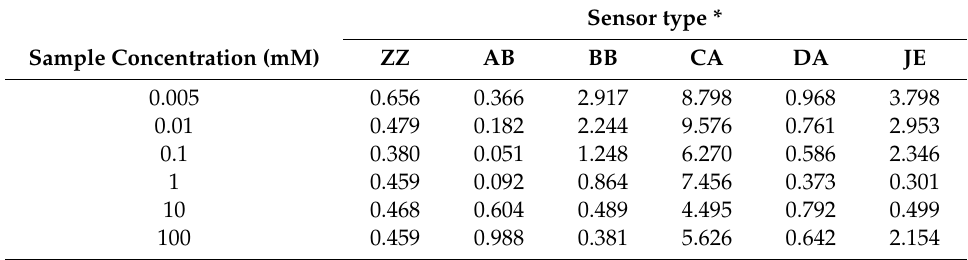
Table 2. Relative standard deviation (RSD) values (%, n = 3) for the e-tongue sensors in the intra-day repeatability